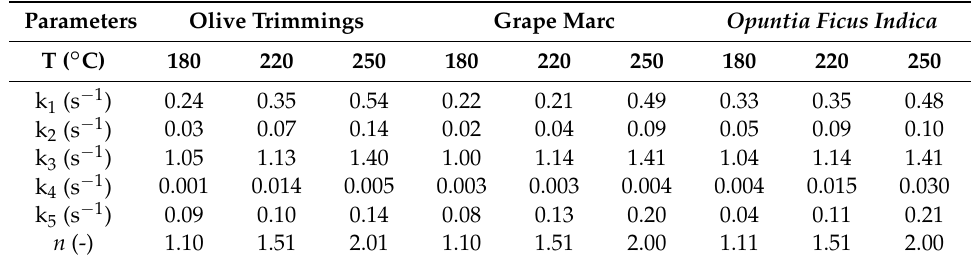
Table 2. Reaction rate constants (k i ) and reaction order ( n ) for the simplified reactions path of Figure 2. Parameters Olive Trimmings Grape Marc Opuntia Ficus